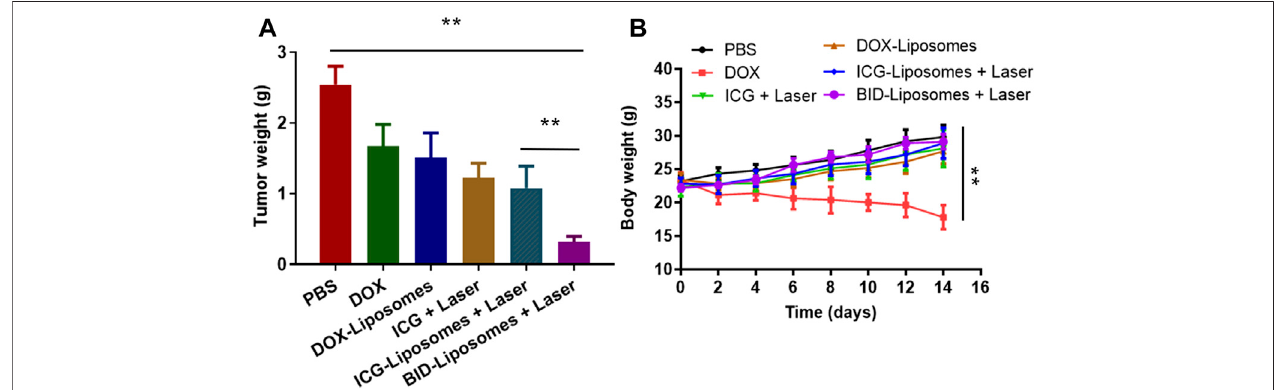
FIGURE7| In vivo chemo-photo-thermaltherapyagainst 4T1breast cancer-bearing mouse models. (A) Tumorweight ofdifferentgroups ofmiceafter treatments with various therapy regimes. (B) Body weight change curve of different mice. The number of mice in each group ( n (cid:1) 6) (mean ± SD; ** p < 0.01; ns, not signi fi cant).